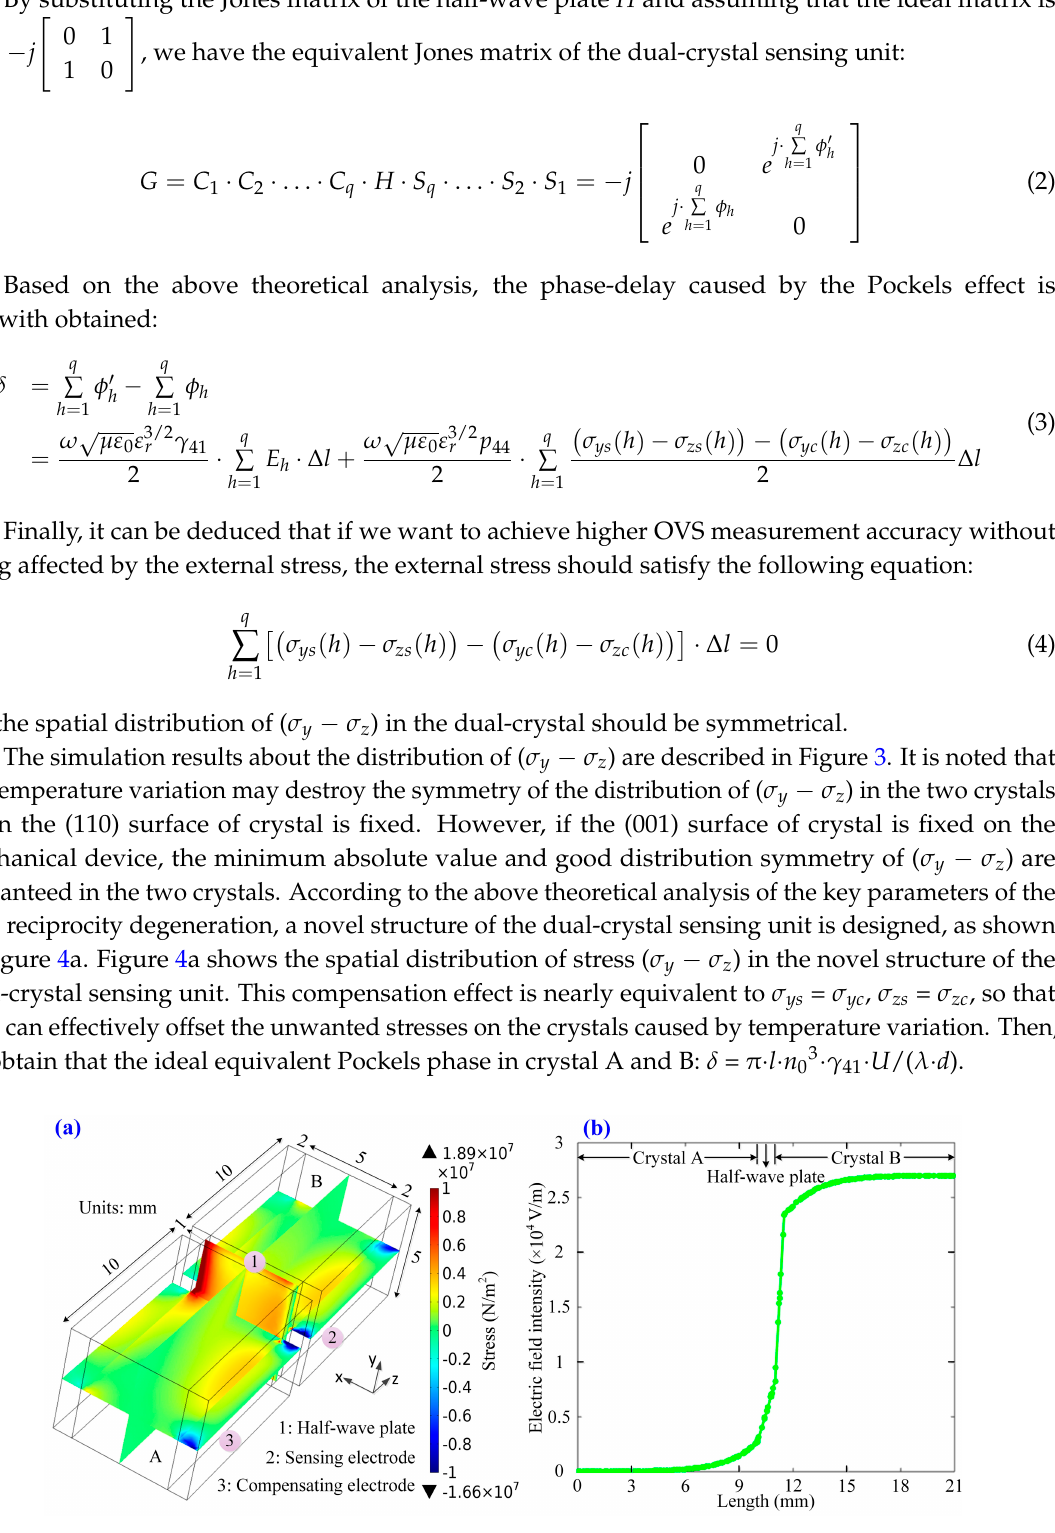
Figure 4. ( a ) The distribution of ( σ y − σ z ) in the designed dual-crystal sensing unit; ( b ) the distribution of electric field when the electrodes of the crystal B is applied with a voltage 1 kV.